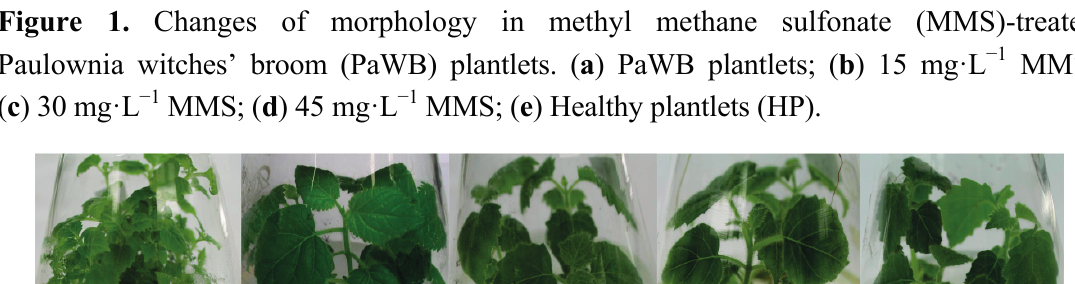
Figure 1. Changes of morphology in methyl methane sulfonate (MMS)-treated Paulownia witches’ broom (PaWB) plantlets. ( a ) PaWB plantlets; ( b ) 15 mg·L − 1 MMS;